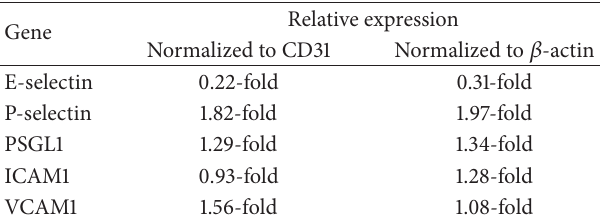
Table 2: Comparison of CD31 and 𝛽 -actin normalized qPCR data.